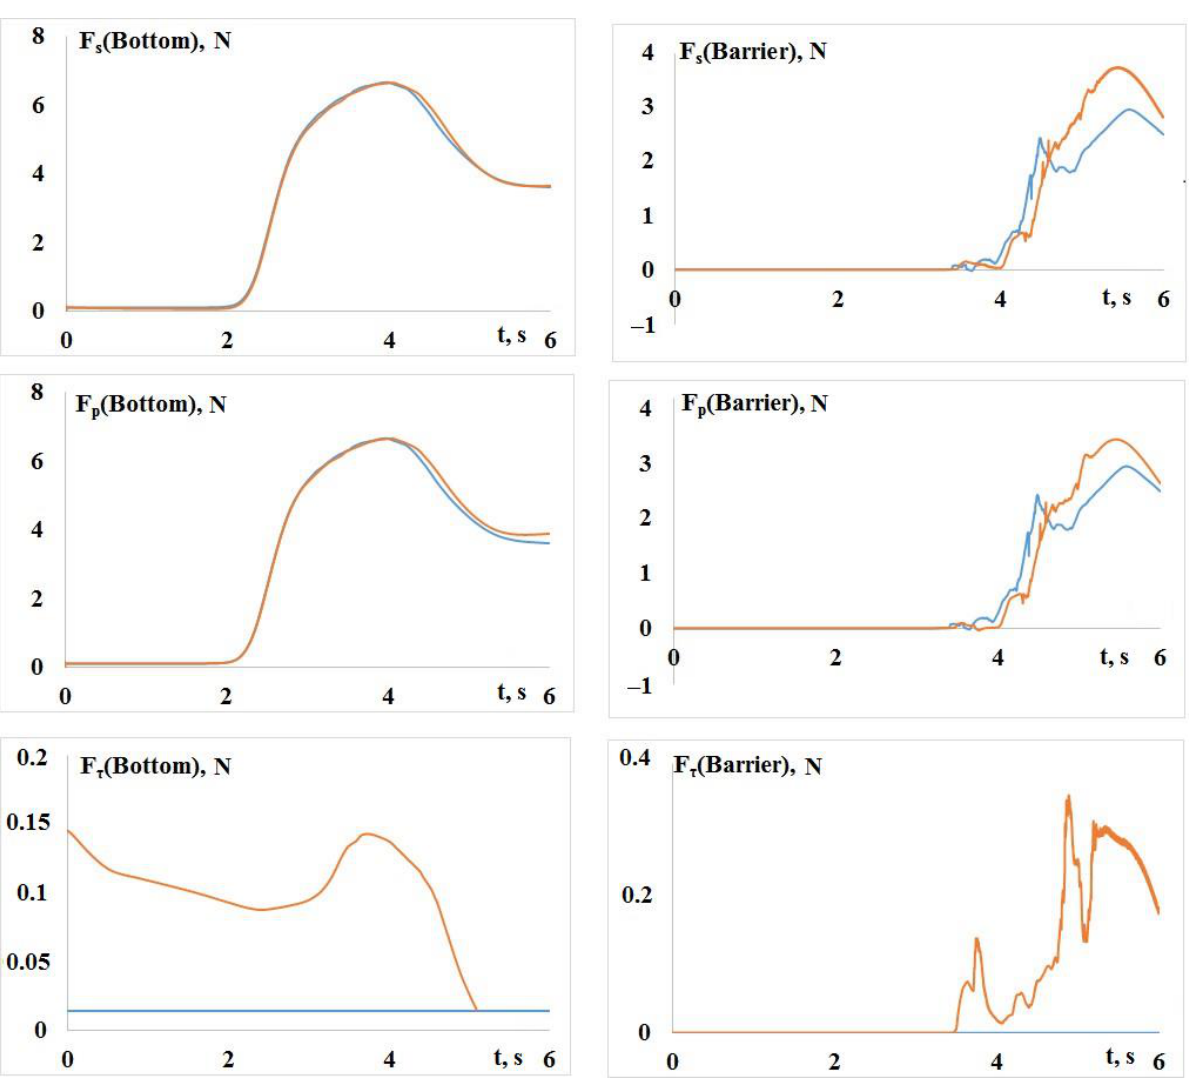
Figure 13. Comparison of the forces acting on the channel bottom in the slope and barrier zones for setup 4 ( —without TM, —with TM).